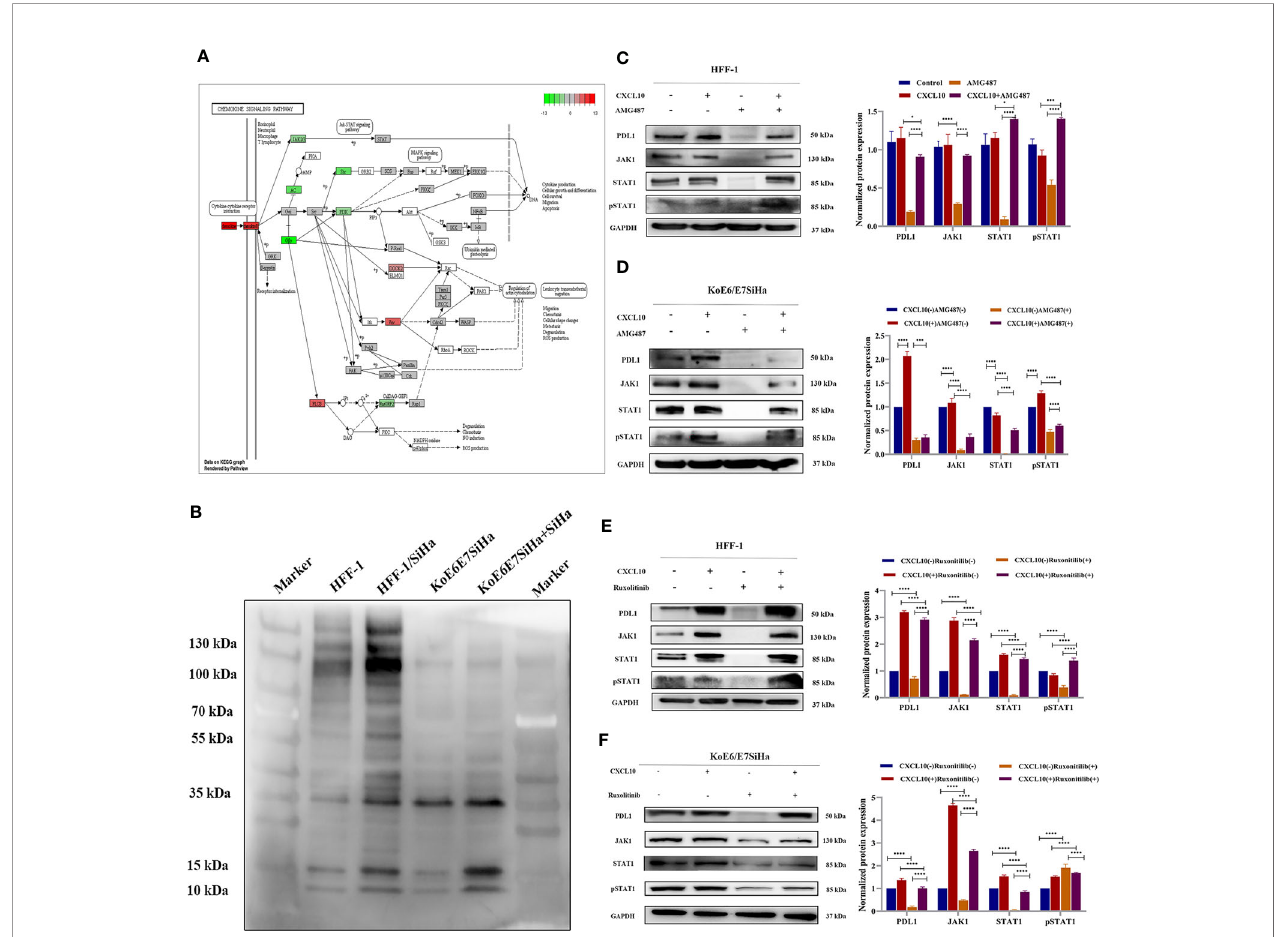
FIGURE 4 | CXCL10-CXCR3 upregulated PD-L1 expression by activating the JAK1-STAT pathway in HPV+ cervical cancer cells and tissues. (A) Map of chemokine signaling pathways generated by KEGG pathway analysis in DAVID by RNA-seq from Aksomics company; (B) The results of pan-phosphorylation western blot detection on the cells including HFF-1, HFF-1 co-cultured with SiHa, KoE6/E7 SiHa, and KoE6E7SiHa co-cultured with SiHa cells. (C – F) The expression of PD-L1, JAK1 and STAT1 in HFF-1 or KoE6/E7 SiHa cells after treatment with recombinant human CXCL10, AMG487 or ruxonitilib, to further verify the HPV E6/E7 can induce upregulated expression of PD-L1 in CSCC through CXCL10 binding to CXCR3 which leads to JAK-STAT pathway activation. *P < 0.05, **P < 0.01, ***P<0.001 and ****P < 0.0001, as determined by Student ’ s